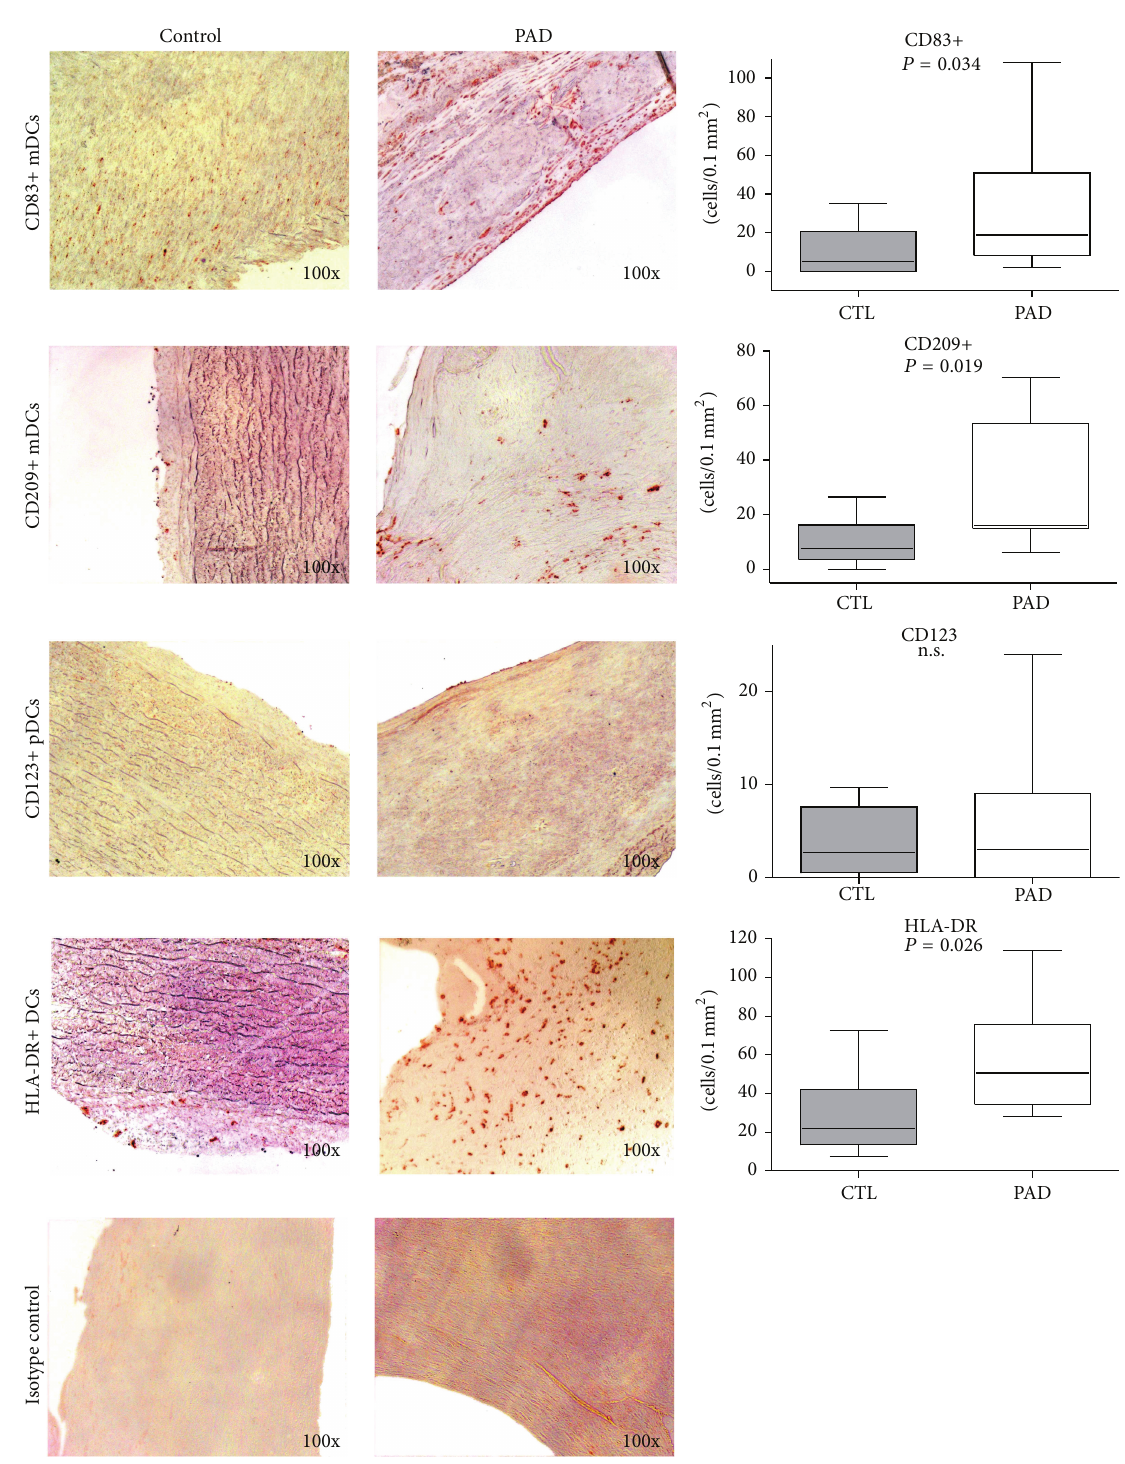
Figure 5: Emergence of myeloid and plasmacytoid DCs as well as antigen-presenting cells in femoralis plaques. CD209+ immature mDCs, CD83+ mature mDCs, CD123+ pDCs, and HLA-DR+ activated APCs in control vessels and femoralis plaques. Also shown: negative (isotype)